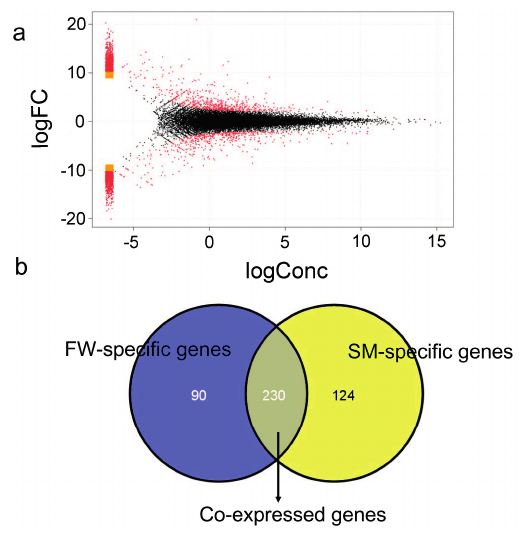
Figure 3. Differential expressed genes between fresh water (FW) and spawning migration (SM) livers. ( a ) MA (Log ratios–mean average) plots showing gene expression in the liver. The y -axis represents the logarithm of fold change and the x -axis represents the logarithm of transcript counts. M is the log ratio of the two dyes used in the hybridization, and A is the average of the log intensities; ( b ) Venn diagram displays the number of FW-specific, SM-specific, and co-expressed